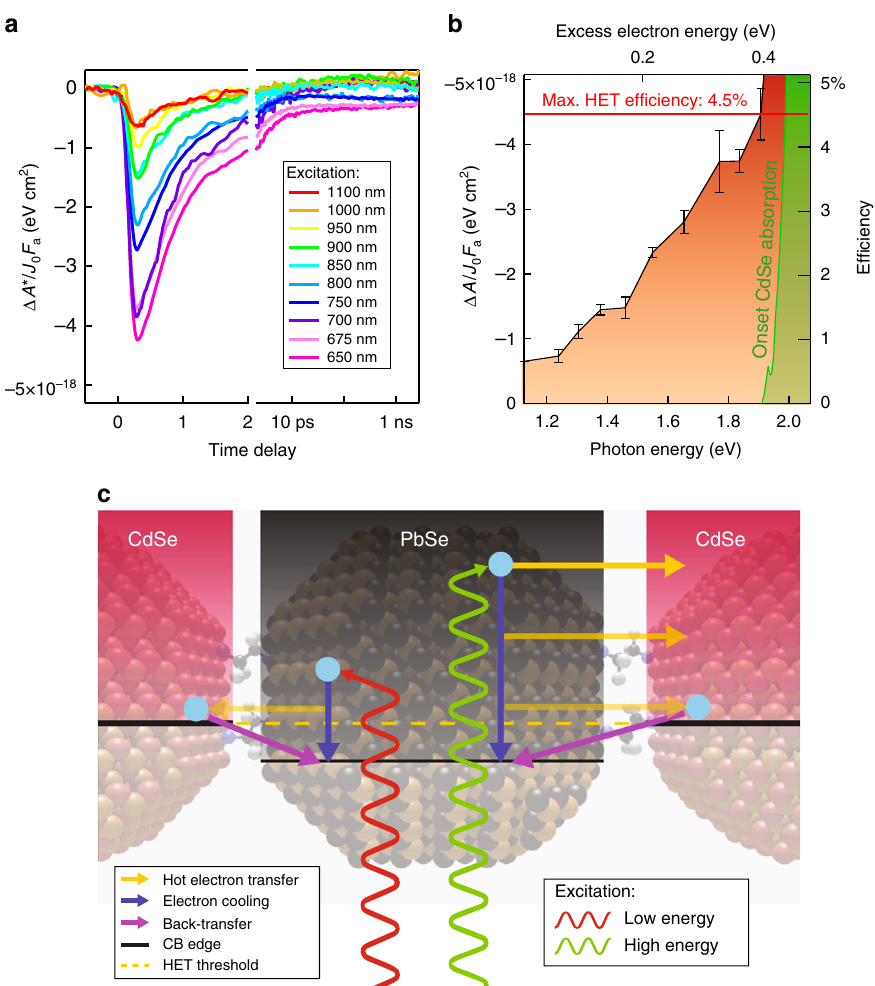
Fig. 4 Excitation energy dependence of hot-electron transfer. a Fitted amplitude of the CdSe bleach component as a function of time, plotted for different excitation wavelengths. The plot shows an increase of the maximum bleach amplitude for shorter excitation wavelengths. b Plot of the bleach amplitude maxima as a function of excitation energy. The right axis shows the hot-electron transfer (HET) ef fi ciency corresponding to each bleach value. Error bars are obtained from the standard deviation of the amplitude maxima, obtained from repeated measurements. c Schematics of the HET dynamics. Upon higher-energy excitation electrons have longer time available to transfer to CdSe QDs before cooling below the HET threshold than electrons excited at lower energy. In addition, transfer rates are expected to be larger for high-energy electrons, due to an increased amount of fi nal CdSe states and more pronounced electron delocalization. The fast decrease of the CdSe bleach is attributed to back-transfer of electron from CdSe to PbSe